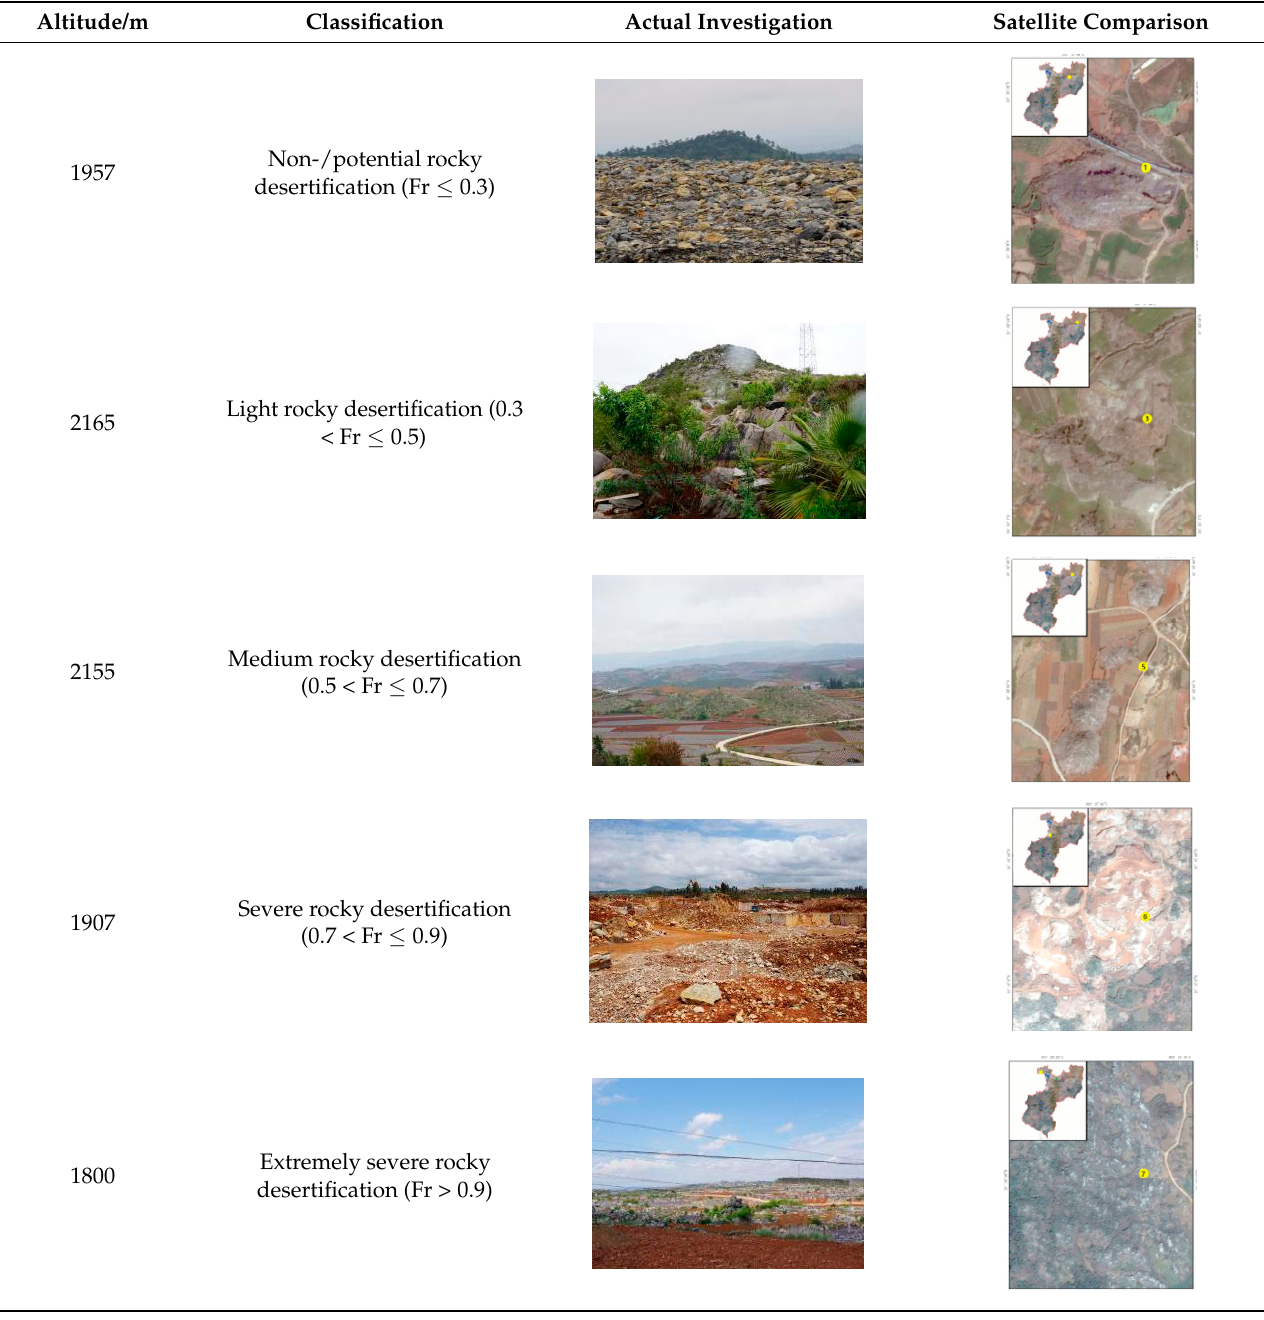
Figure 2. Dynamic evolution of rocky desertification level in the study area from 2000 to 2017.